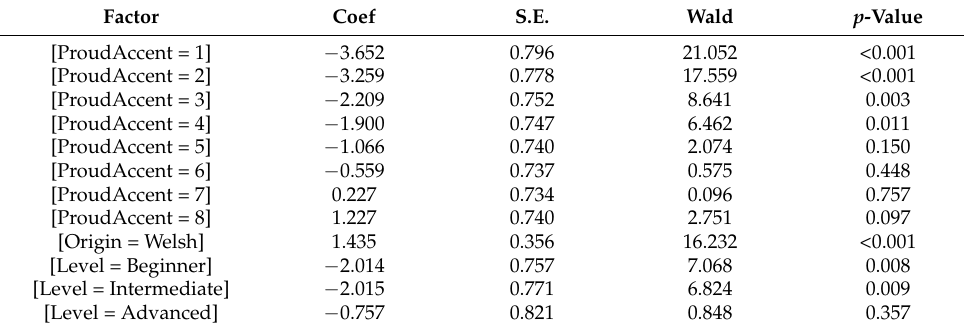
Table A5. Coefficients for I’m proud of my accent when speaking Welsh.